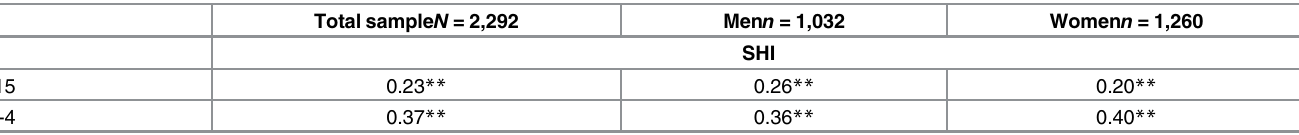
Table 4. Two-tailed Spearman rank correlations between the Self Harm Inventory (SHI), the 15-item Barratt Impulsiveness Scale (BIS-15), and the ultra-brief Patient Health Questionnaire for Depression and Anxiety